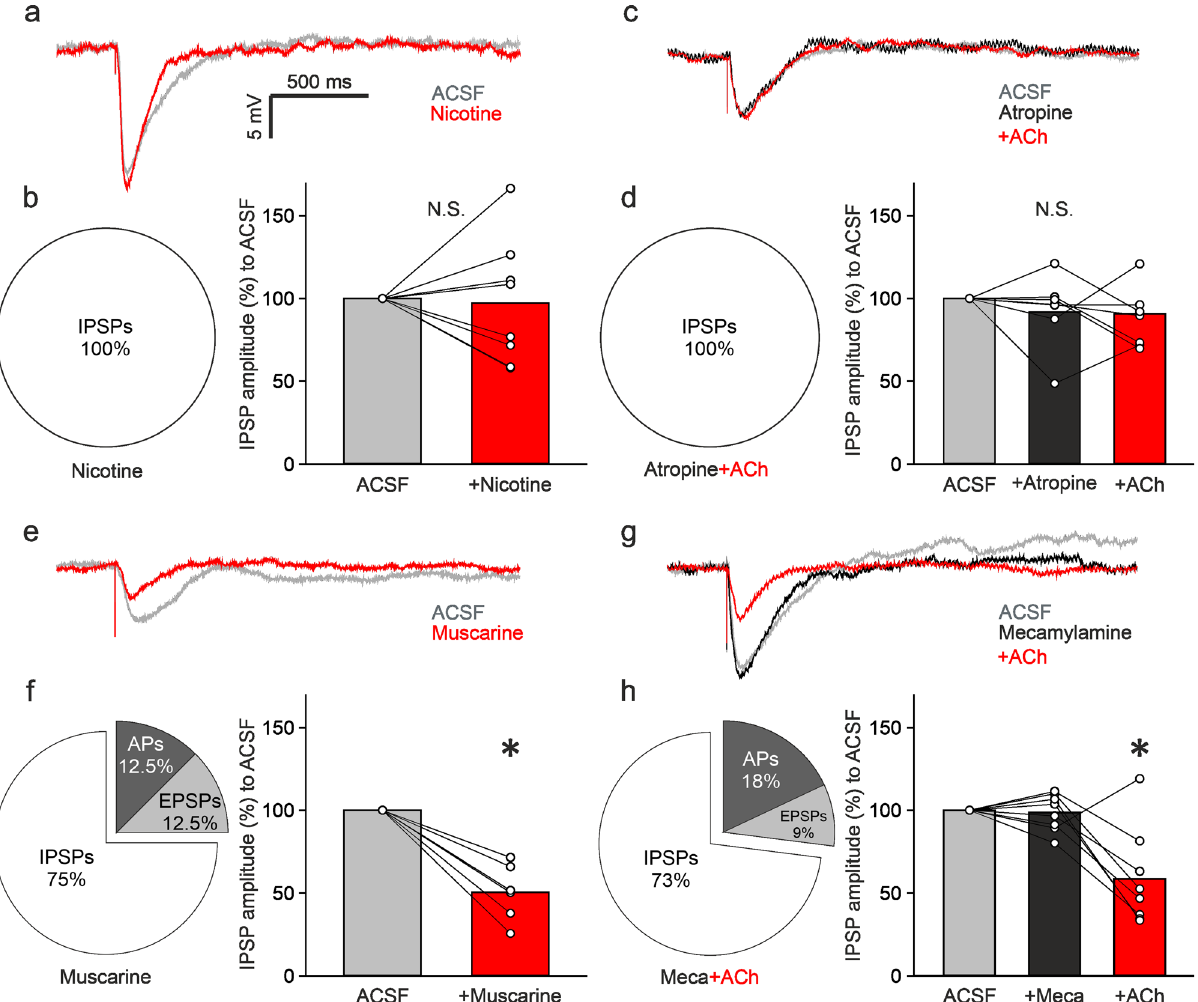
Fig. 4 The muscarinic pathway is responsible for reduction of ON-evoked inhibition. a Representative averaged traces of responses from VPCs following ON stimulation in the ACSF condition (gray) and during bath application of nicotine (100 µ M, red). b Pie-chart represents the proportion of cells showing either APs, EPSPs, or IPSPs ( n = 8 cells). Bar-charts represent cumulative analysis of normalized evoked IPSP amplitudes to the ASCF condition ( n = 8